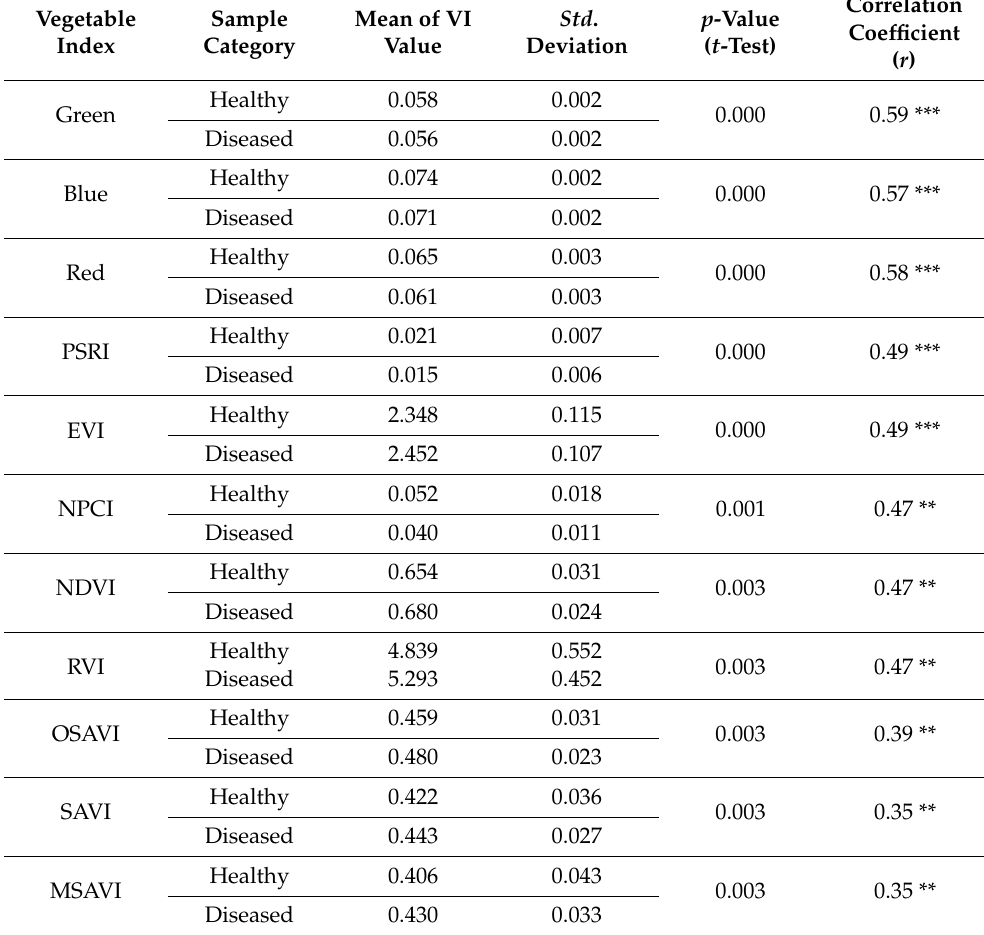
Table 3. Results of independent t -testing and correlation coefficient of feature variables.